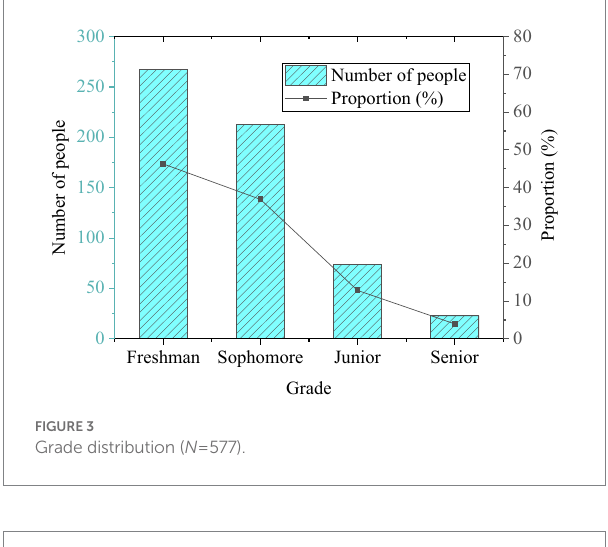
FIGURE 3 Grade distribution ( N = 577).